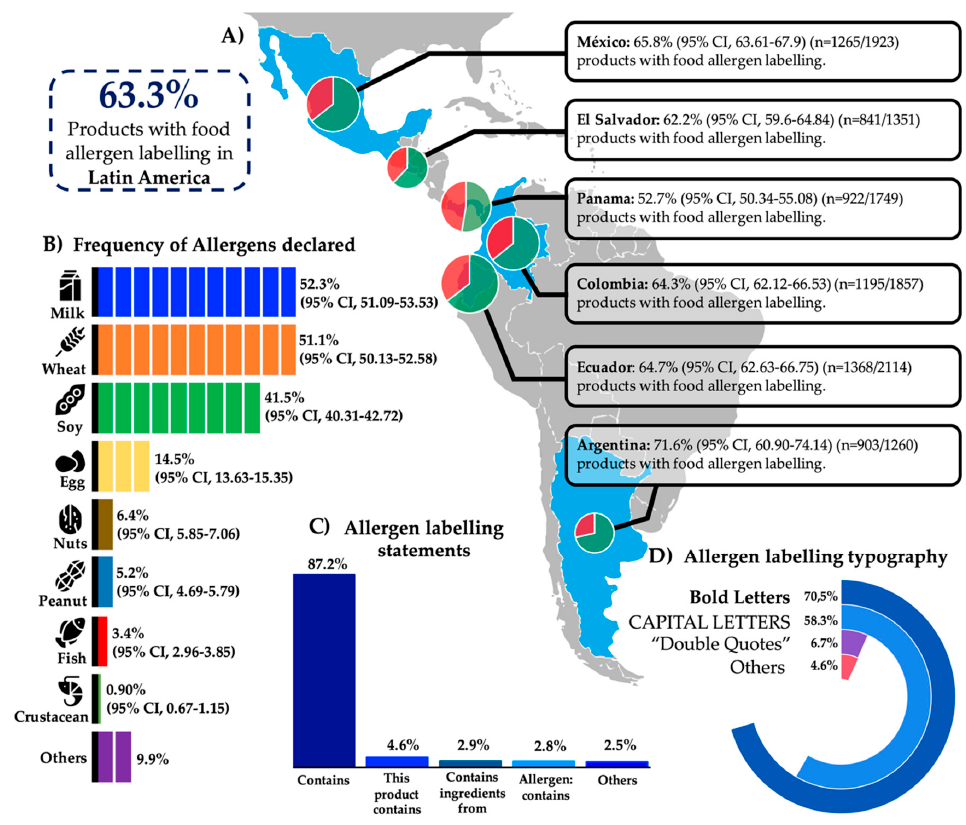
Figure 1. Percentage of products with food allergen labelling and the characteristics of the labelling in commercially available packaged food products in six Latin American countries. ( A ): Percentage of products with food allergen labelling by country (in pie charts: green and red sections; proportions of products with or without food allergen labelling, respectively); ( B ): Percentage of food allergens declared in food allergen labelling; ( C ): Statements used for food allergen labelling; ( D ): Typography used for food allergen labelling (the summation of percentages is greater than 100% due to the use of two or more typographical characteristics in combination) .